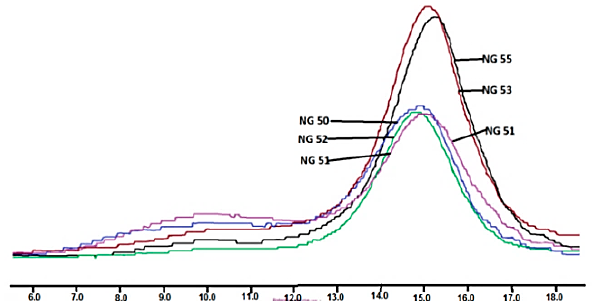
Figure 4. GPC elugrams of poly( L -lactide)– block –poly(butylene succinate– co –butylene citrate) and poly( L -lactide)– block –poly(butylene citrate).